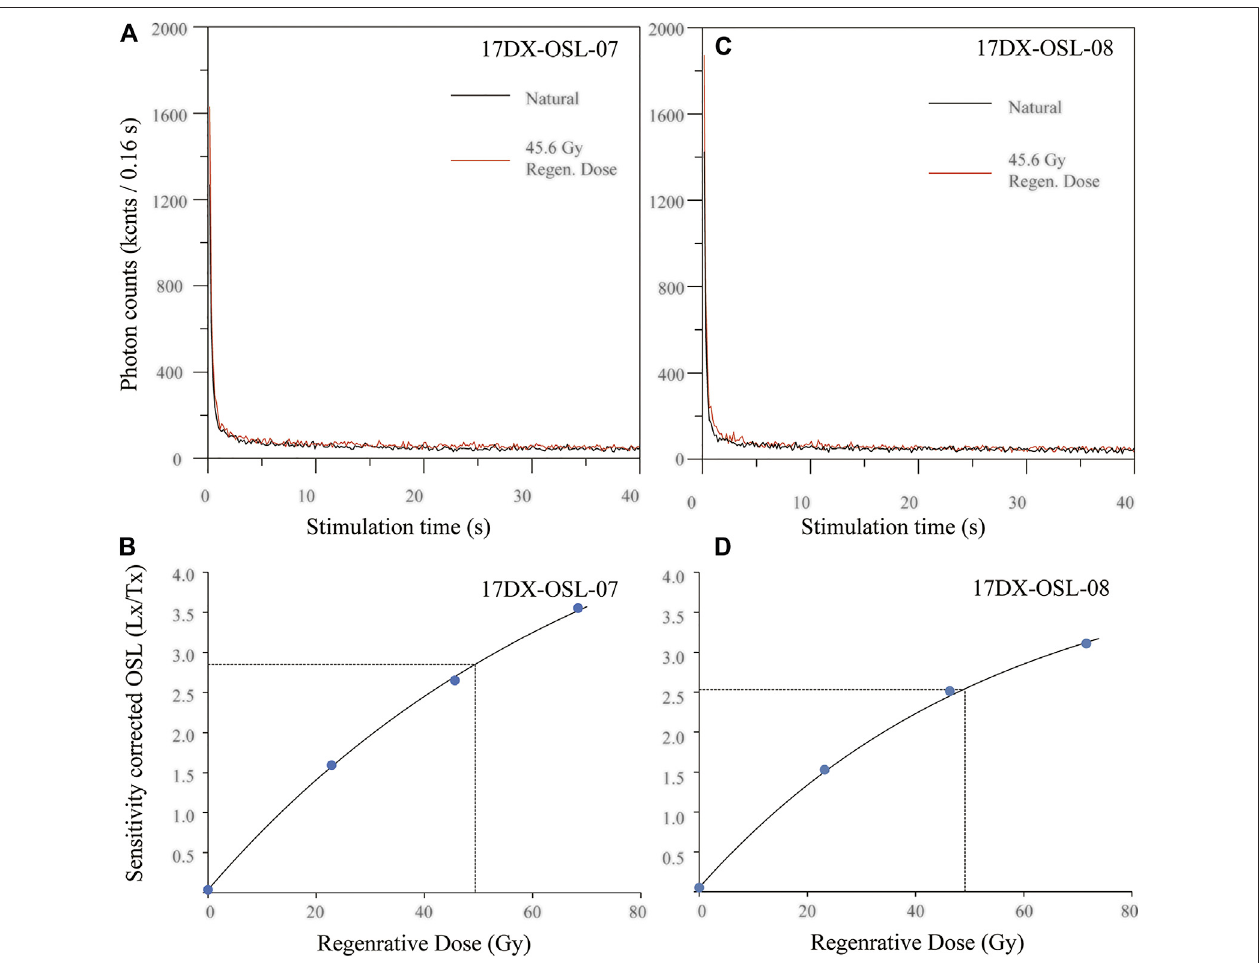
FIGURE2|(A) OSL decay curves fornatural dose and regenerative doseof48.6 Gyof17DX-OSL-07; (B) Doseresponsecurve of17DX-OSL-07; (C) OSLdecay curves for natural dose and regenerative dose of 48.6 Gy of 17DX-OSL-08; (D) Dose response curve of 17DX-OSL-08.